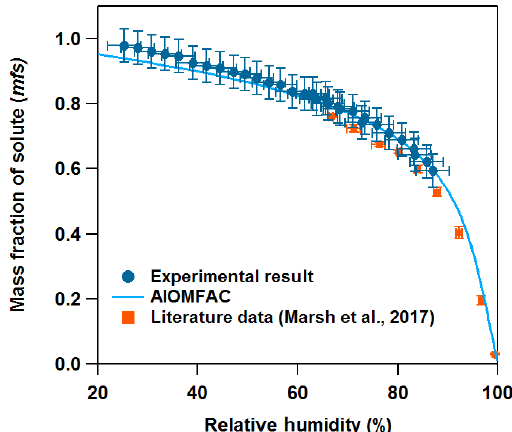
Figure 1. Hygroscopicity of methylsuccinic acid droplets ( ∼ 10µm diameter) measured using an aerosol optical tweezers setup at a temperature of 295K and corresponding prediction by the AIOM- FAC model. The orange markers denote experimental hygroscopic- ity data by Marsh et al.